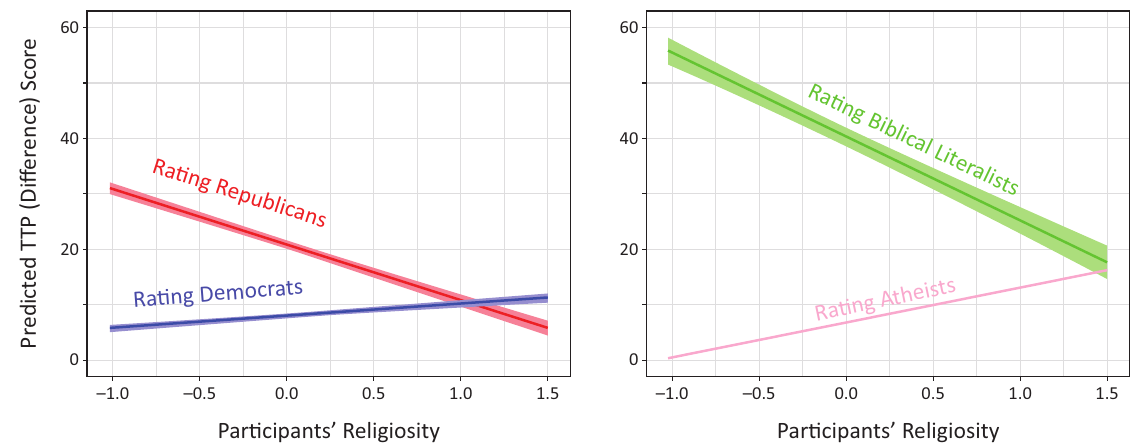
Figure 2. Predicted TPP scores (‘other’ minus ‘self,’ i.e., difference score) when rating how much more